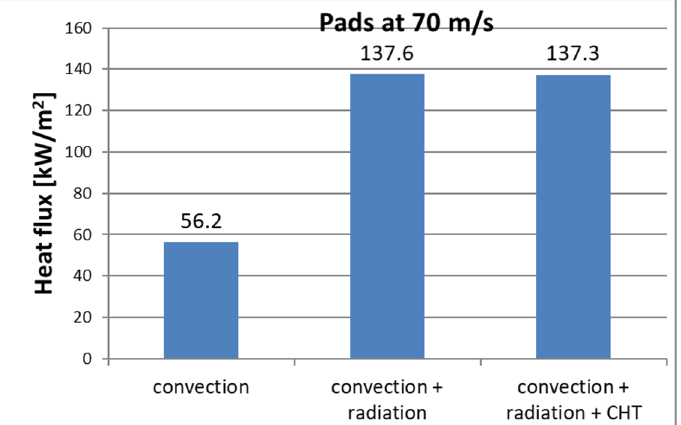
Figure 19. Comparison of heat dissipation results from the disk with different heat transfer mechanisms at 70 m/s.